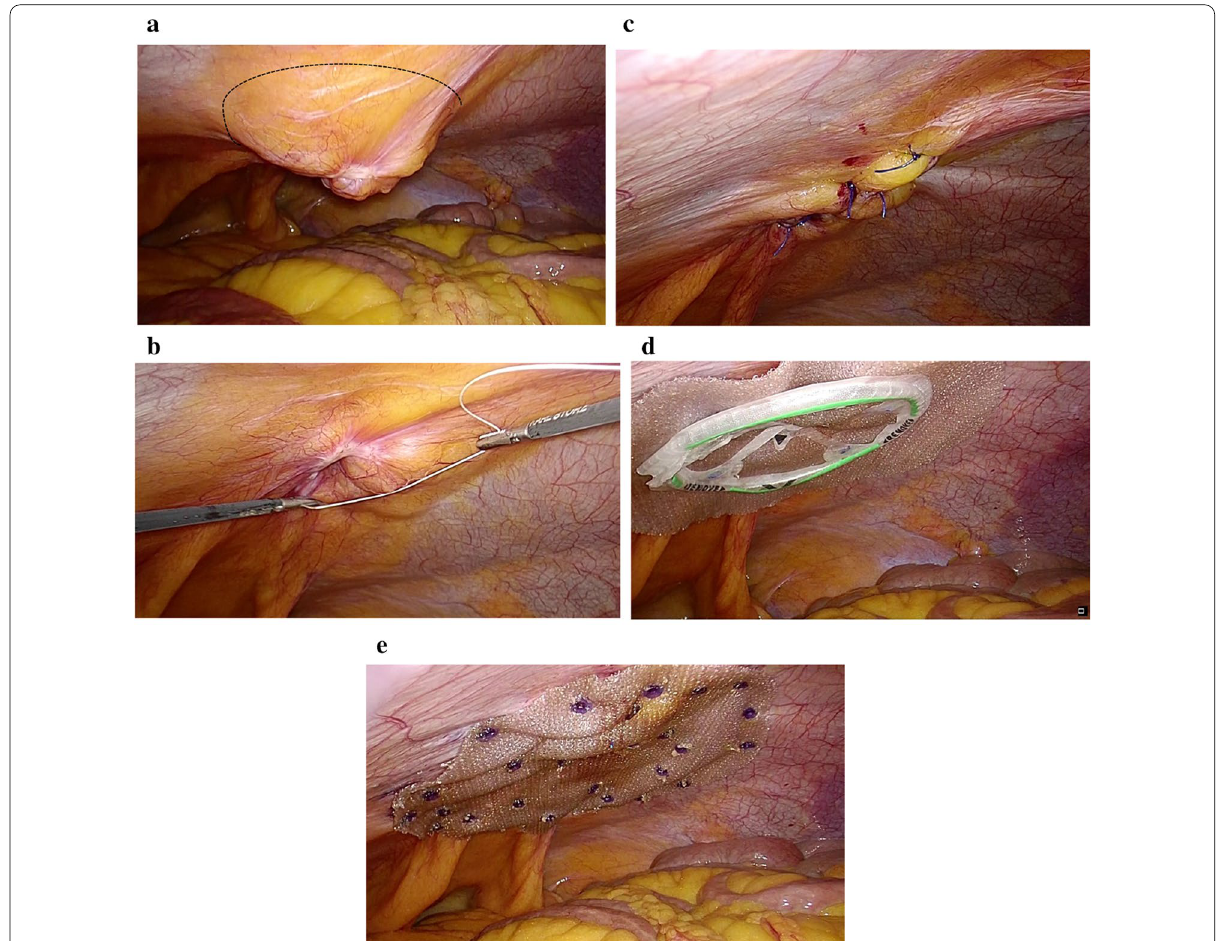
Fig. 4 Intracorporeal procedure for umbilical hernia. a Palpation of the hernial orifice (circle). b Measurement of the hernial orifice. c Closure of the hernial orifice with simple interrupted sutures. d Temporarily securing the mesh with an attachment to help facilitate deployment. e Securing the mesh using the double-crown